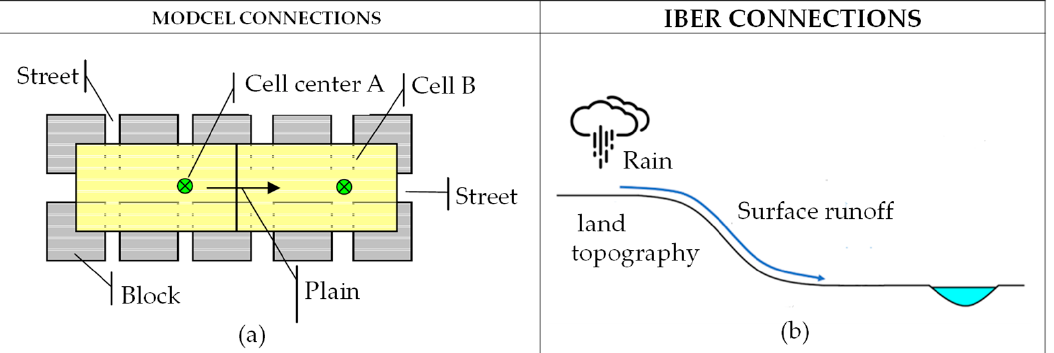
Figure 2. Adaptation of MODCEL connections to IBER options: ( a ) plain connection (the simplest), not required in IBER; ( b ) rainfall runoff and surface runoff processes in IBER. Source: own elabora- tion from [33,34].